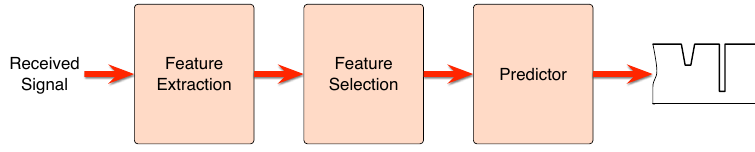
Figure 8. Scheme of an SSP